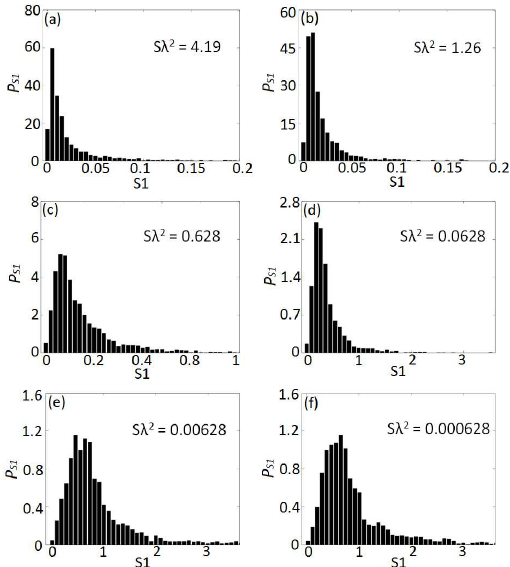
Figure 14. Level statistics of first-neighbor eigenvalues in the complex plane for an N = 1000 random array with S λ 2 values as indicated in the panels. In the case of random systems we can write k (cid:96) =2 π / ( S λ 2 ) where (cid:96) provides is the scattering mean free path in the system. The value of first level spacing, S 1 , is computed at the nearest neighbor distance between eigenvalues in the complex plane for each eigenvalue, and is normalized by the average S 1 for each case. The probability density is normalized such that the total probability equals to